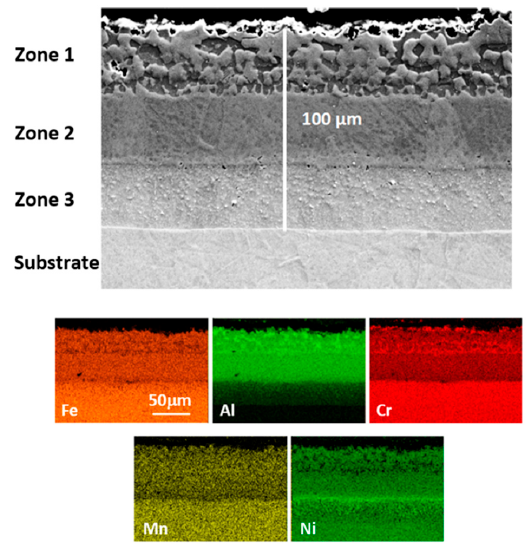
Figure 1. FESEM cross section SE image and EDS element map of a slurry aluminide coating deposited on HT347HFG steel after being heat treated for 1 h at 700 °C and 2 h at 900 °C.